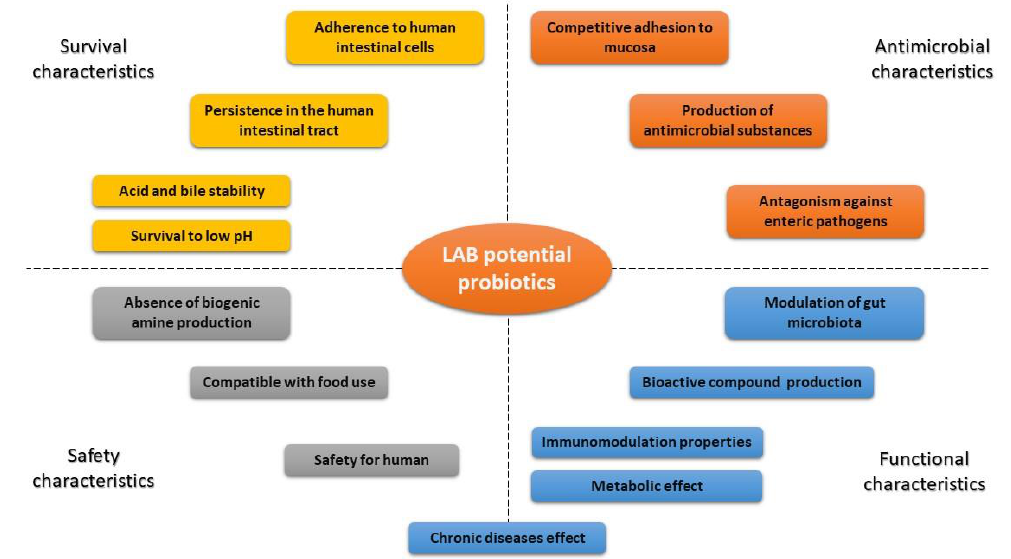
Figure 2. Probiotic strains characteristics of selection for fermented fruit and vegetable beverages.